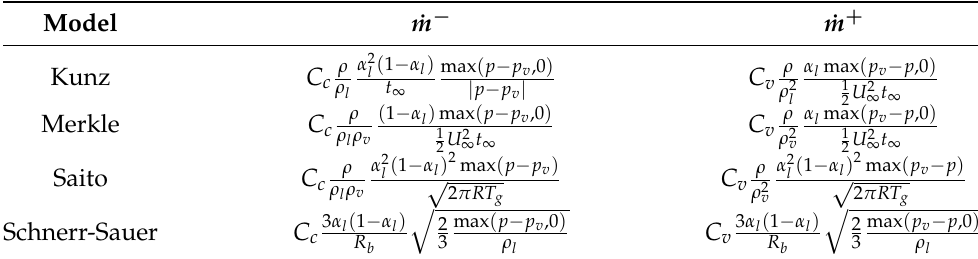
Table 1. Source terms for the non-conservative form of the transport Equation (Equation (3)), according to the cavitation models considered.